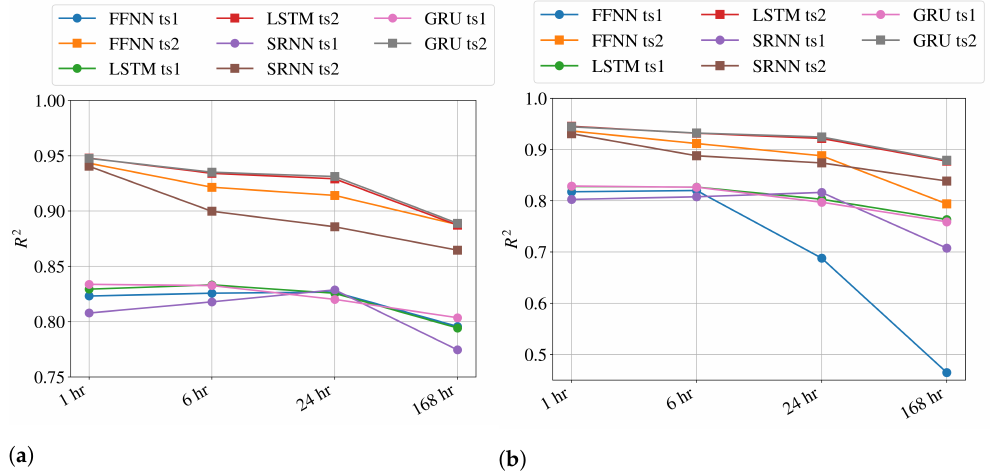
Figure 7. Results of ANN tuning ( R 2 in y-axis) of ts 1 synthetic time series (solid lines and circle markers) and ts 2 real time series (solid lines and square markers) for the 4 forecasting horizons (x-axis) with the set of inputs 2. ( a ) depicts the best model for each architecture per horizon, while ( b ) shows the mean R 2 of the models for each architecture per